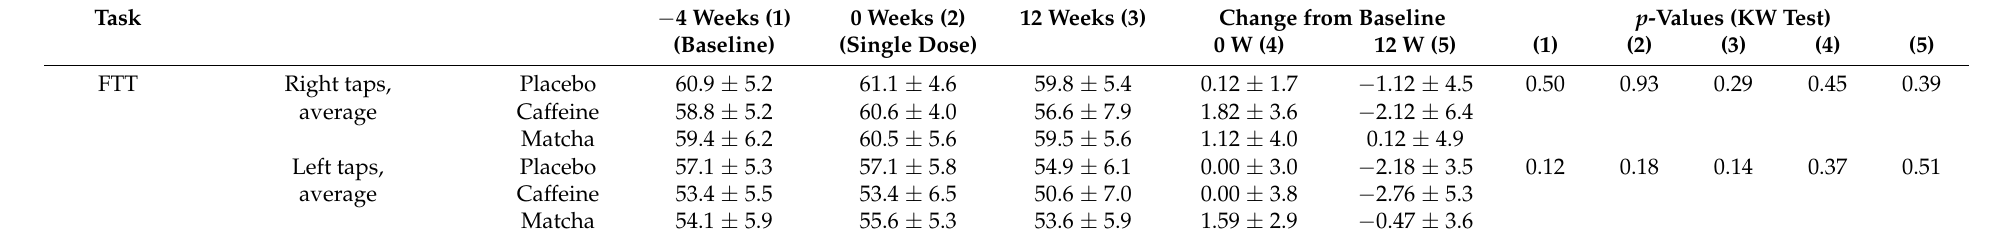
Table 9. Effect of matcha or caffeine intake on motor function-related